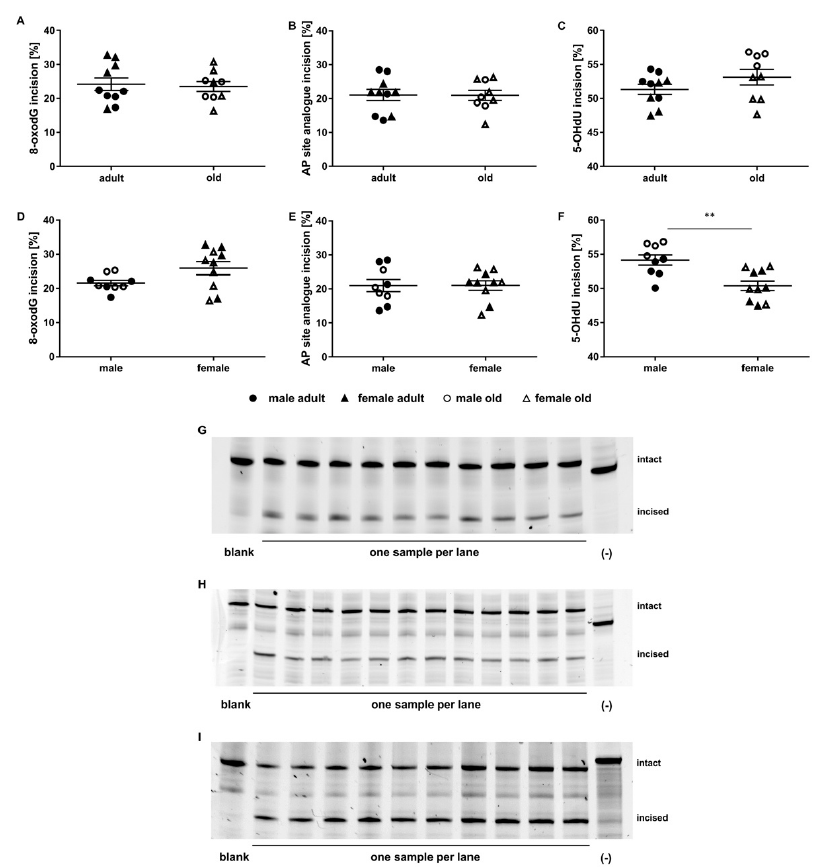
Figure 3. Impact of age and sex on incision activity. Shown is BER incision activity (individual single measurement scores per animal and group mean ± SEM) of murine liver of adult (24 weeks, n = 10) and old (109-114 weeks, n = 9) animals of both sexes (female: n = 10, male: n = 9) towards ( A , D ) the 8-oxodG, ( B , E ) the AP site analogue, and ( C , F ) the 5-OHdU containing oligonucleotide. Additionally, one representative polyacrylamide gel is shown for ( G ) the 8-oxodG, ( H ) the AP site analogue, and ( I ) the 5-OHdU containing oligonucleotide (full-length gels shown in Figure S3). The left lane shows the respective oligonucleotide blank followed by single sample measurements per lane and a negative control (as described above, marked as (-)) in the right lane. t-test, ** p ≤ 0.01.